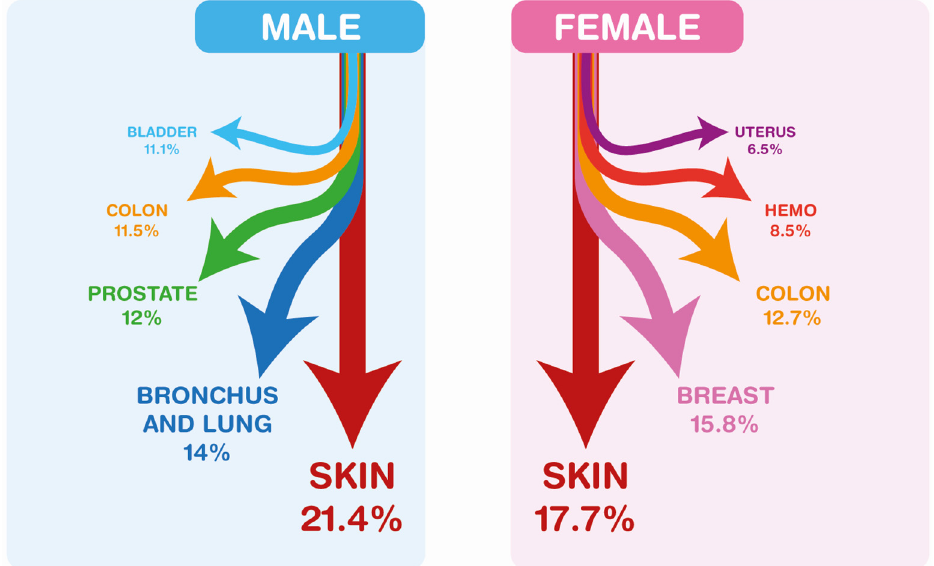
Figure 2. Sites of second primary cancers, shown by decreasing frequency of occurrence. The most frequent SPC sites are detailed, in decreasing order from bottom to top; other cancers, combined, represented 30.0% in males and 38.8% in females (data in Table S5 of the Supplementary Materials).